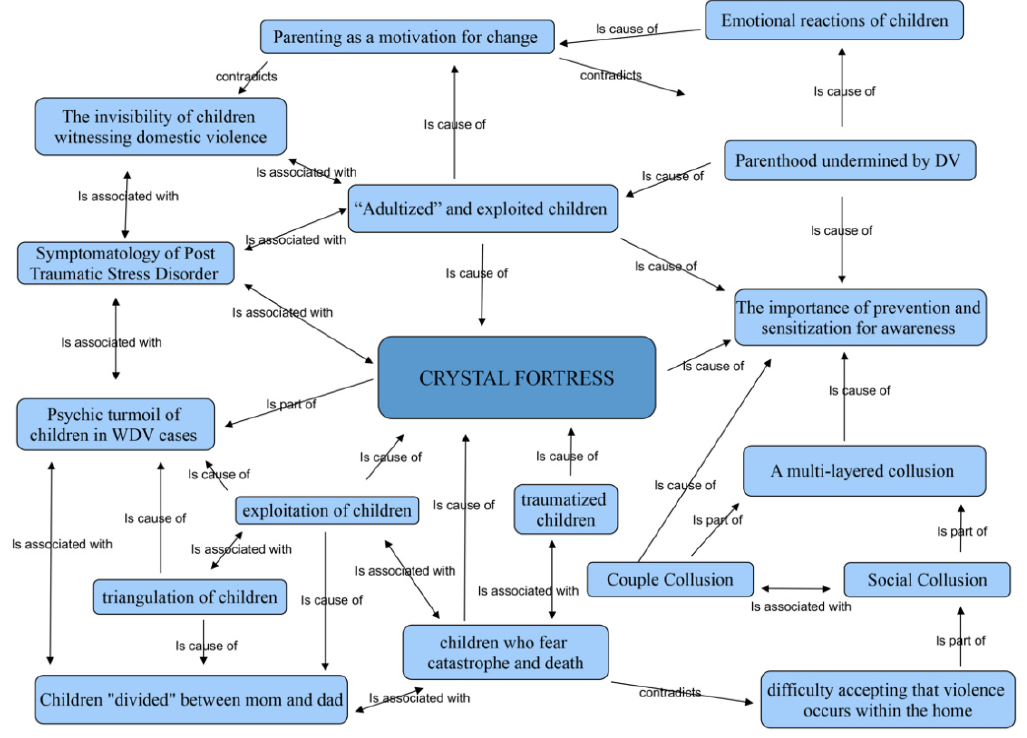
Figure 1. Network of “The Crystal Fortress”. This figure describes the relationships among the Core Category and significant elements that emerged from the analysis of the texts.